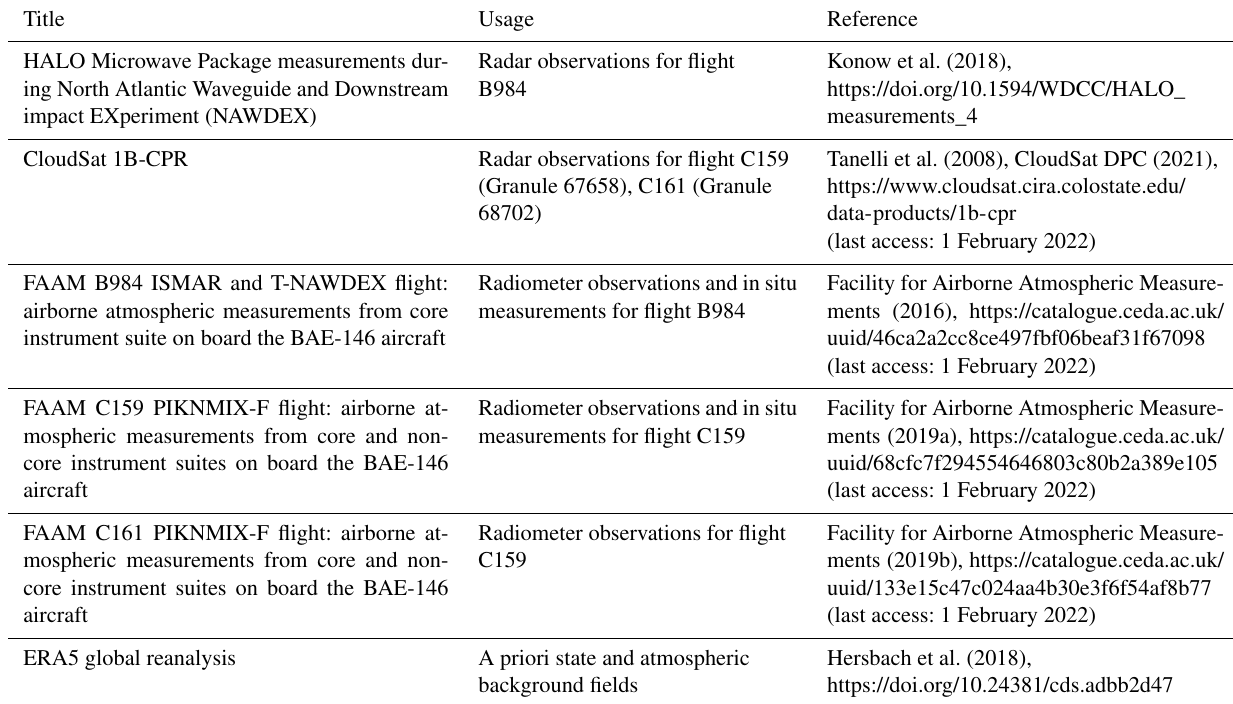
Table 1. Datasets used in the this study. Title Usage